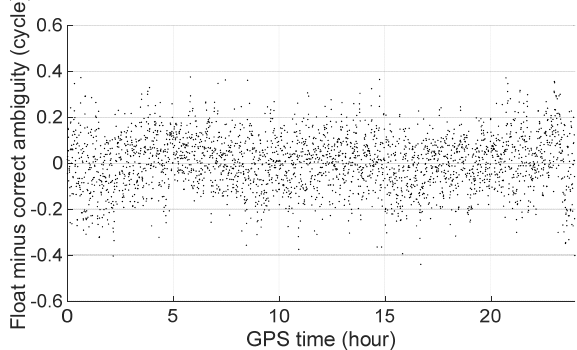
Figure 9. Inter ‐ GNSS wide ‐ lane ambiguity resolution. Table 9. Fixing rate of the single ‐ epoch inter ‐ GNSS wide ‐ lane ambiguity resolution (%). GNSS